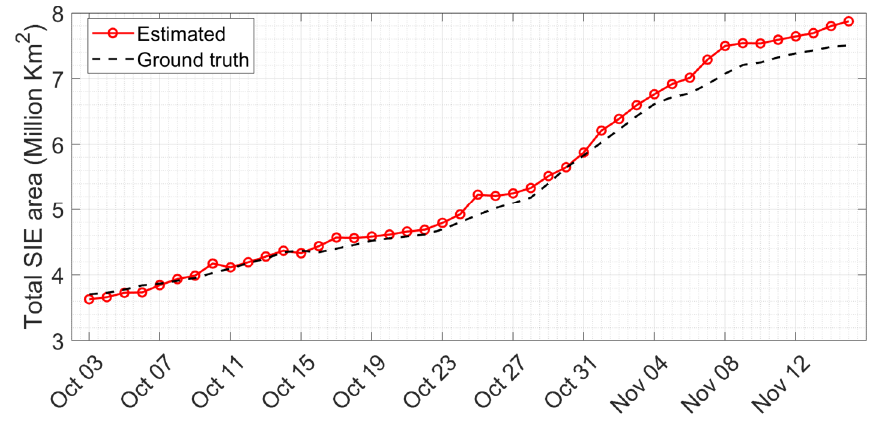
Figure 13. Total Arctic sea ice extent area.